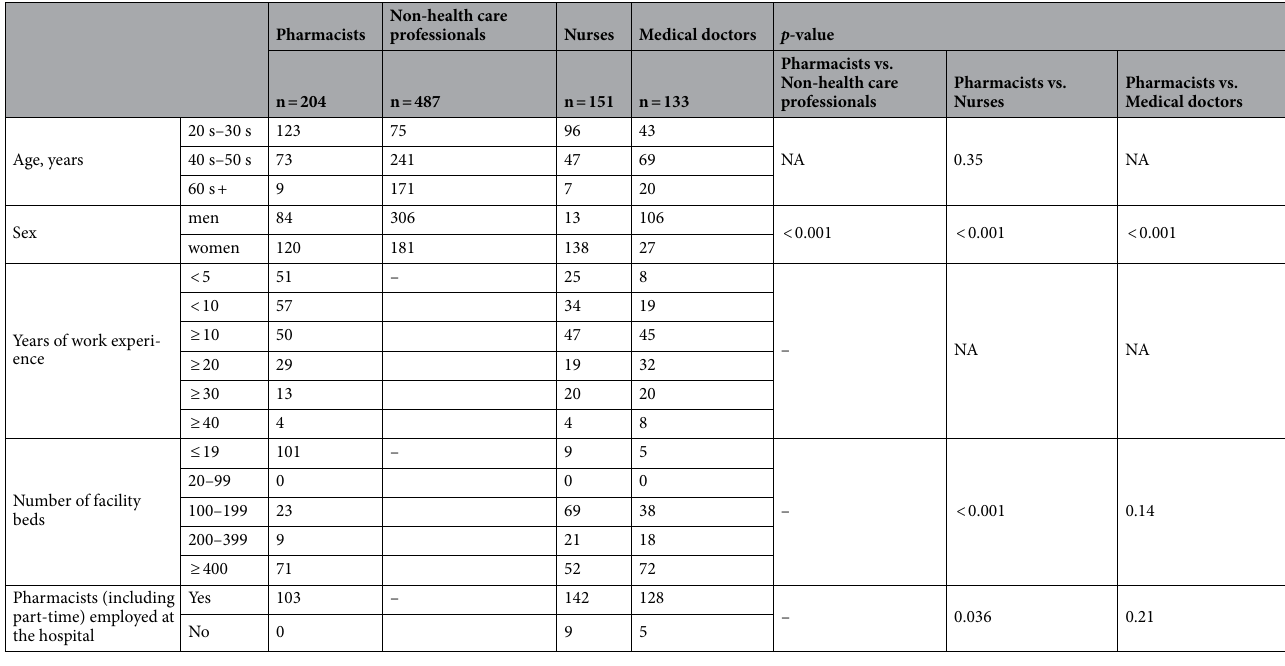
Table 1. Characteristics of participants.